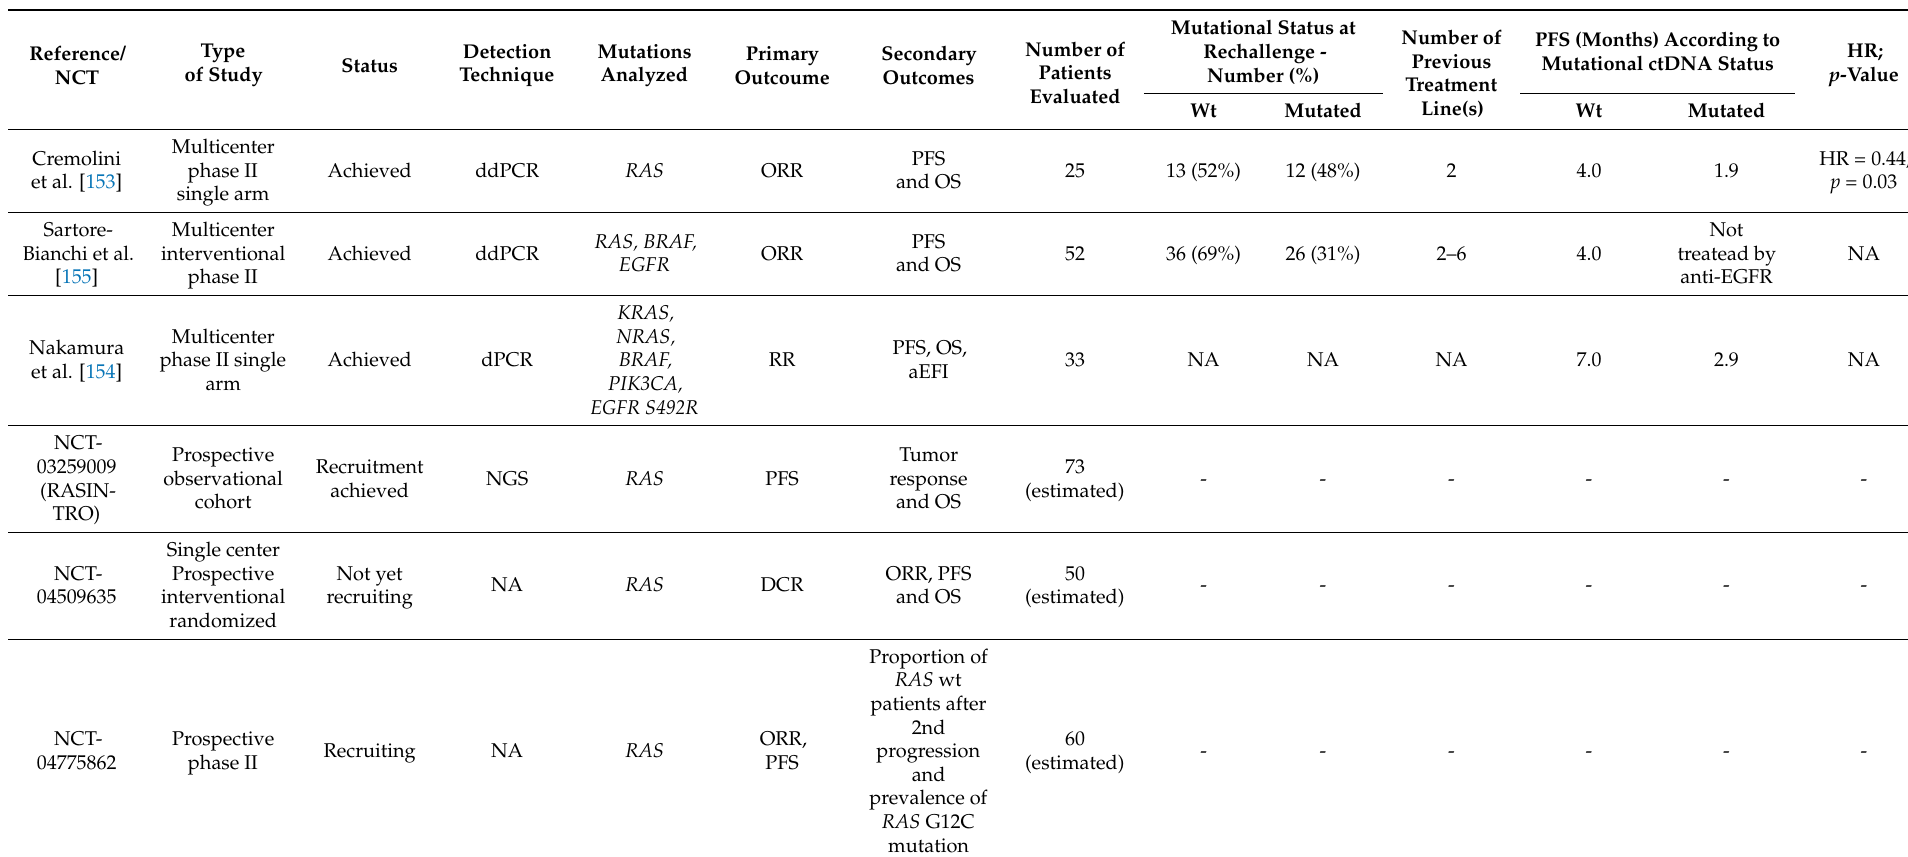
Table 3. Studies evaluating circulating tumor DNA as a screening tool to detect patients who could benefit from anti-EGFR re-challenge in metastatic colorectal